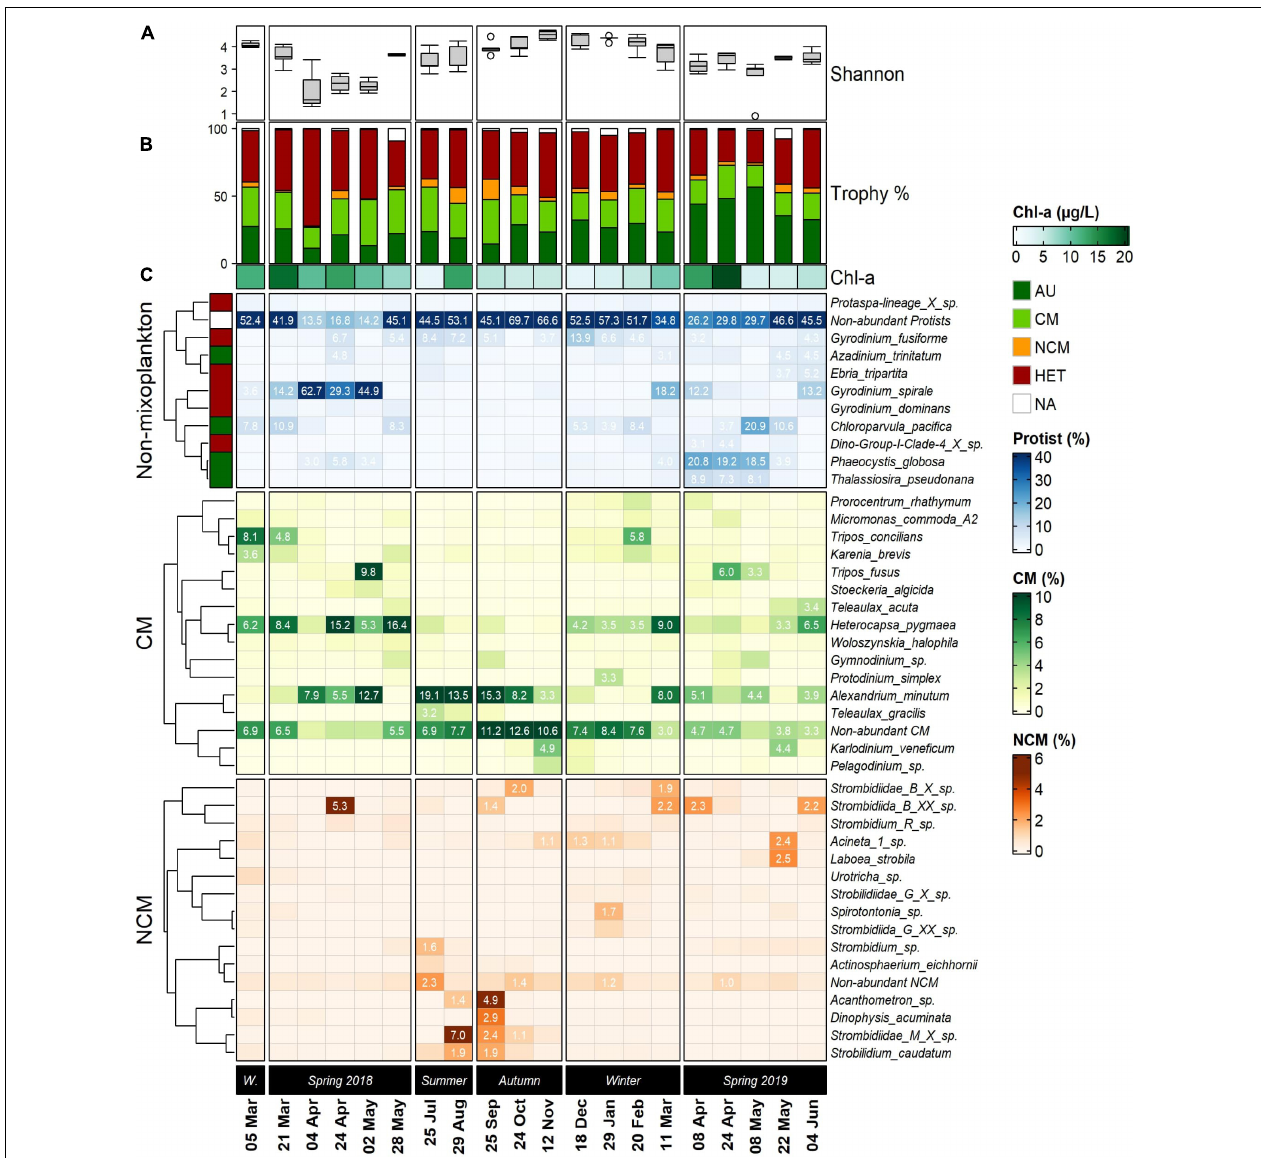
FIGURE 5 | Series of seasonally arranged heatmaps displaying the community composition in the Belgian Coastal Zone temporal samples (five stations averaged). The top 10 most abundant non-mixotrophic protists are displayed in blue, which included strict auto- and heterotrophic organisms. Below, the top 15 constitutive mixoplankton (CM) and non-constitutive mixoplankton (NCM) are displayed in green and orange, respectively. (A) Boxplots displays the temporal progression of the entire community Shannon diversity index at each temporal sample. (B) Colored stacked bar plots represent the proportions of reads of the different trophic strategies. Below, Chl- a concentrations are annotated. (C) Taxonomic affiliation of ASVs at the lowest possible level (species), is shown in lines. Left annotation in colors refers to the trophic modes assigned for each of the non-mixoplankton species. The color scale (blue, green, orange) represents the relative abundances calculated as percentage of final total reads per temporal sample. The results that accounted ≥ 3% were annotated for non-mixoplanktonic protists and CM a ( ≥ 1% for NCM). Row clustering and its corresponding dendrogram was built using Pearson distance. W. = Winter